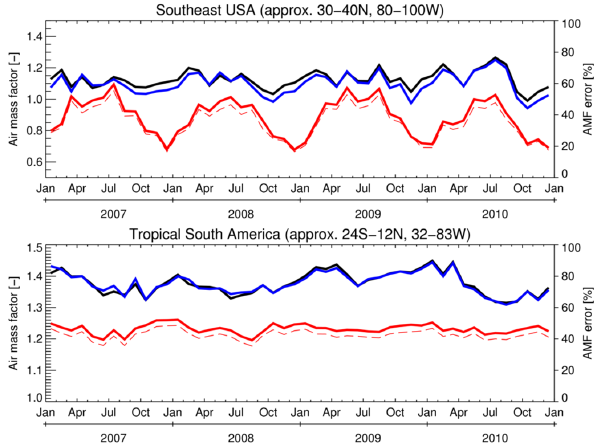
Figure 11. 2007–2010 time series over southeast USA (top) and tropical South America (bottom), showing monthly median AMFs calculated with and without aerosols (solid black and blue lines, respectively), and monthly median total AMF error (red solid line; calculated with aerosols present). The dashed red line shows the contribution to the total AMF error from uncertainty in the HCHO profile